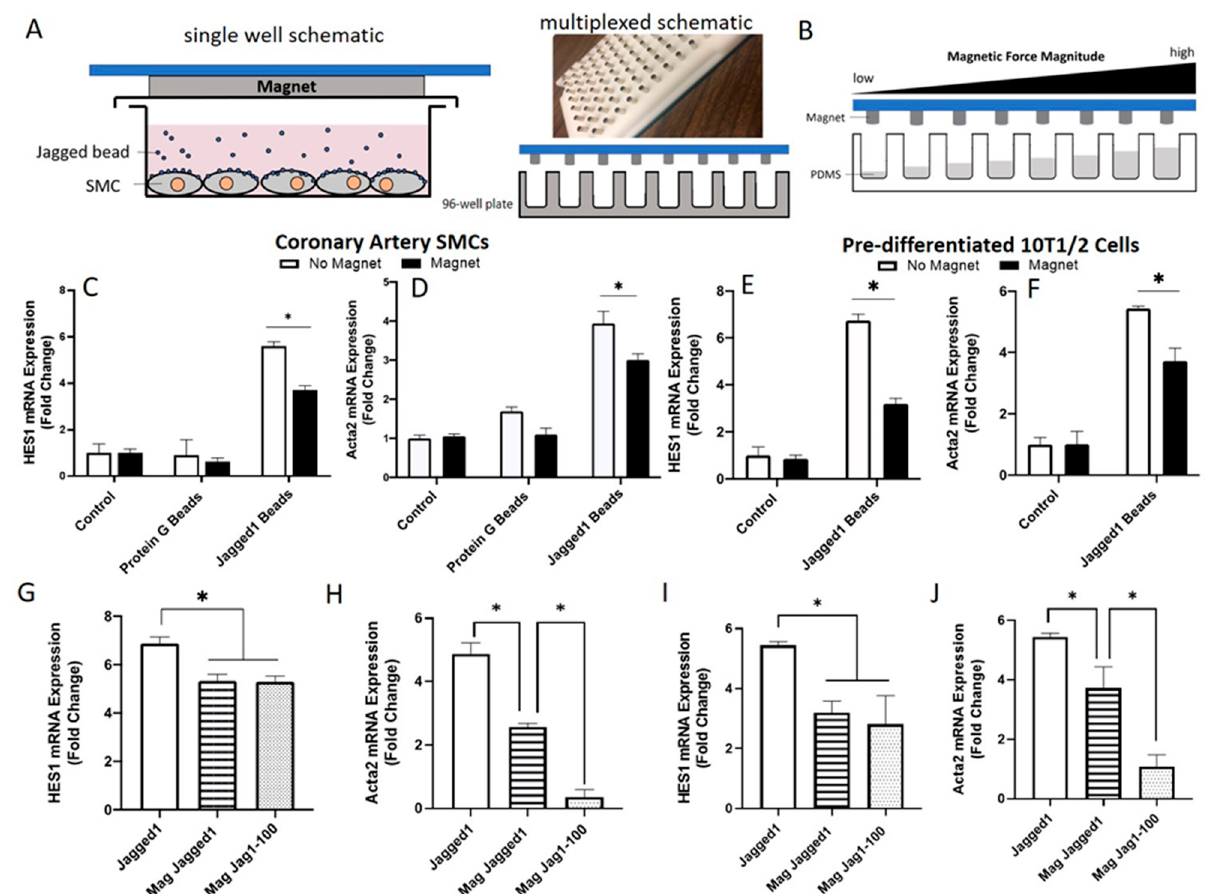
Figure 5. The effect of magnetic tweezer forces in Notch activation. ( A ) Experimental design and set-up. HCASMCs were cultured with Jagged1 bound Protein G beads. A magnetic plate containing 96-cylindrical magnets was positioned over the culture plate with a 1–1 well to magnet ratio to apply a force to the Jagged1 magnetic beads tethered to the Notch3 receptor on HCASMCs or 10T1/2 cells. ( B ) Various volumes of PDMS were dispensed to the wells to create a terraced height between the cell surface and the magnets, where increasing well height corresponds to increased force magnitude. Gene expression of HES1 and Acta2 with and without magnets in HCASMCs ( C , D ) and pre-differentiated 10T1/2 cells ( E , F ). Gene expression of HES1, and Acta2 at two different distances from the HCASMCs surface to the magnets ( G , H ) and from the pre-differentiated 10T1/2 cells ( I , J ). Data presented as the mean ± SD ( n = 3), normalized to magnet control. * indicates significance at p < 0.05. The different distances from the cell surface to the magnet tips are provided in Figure S4.